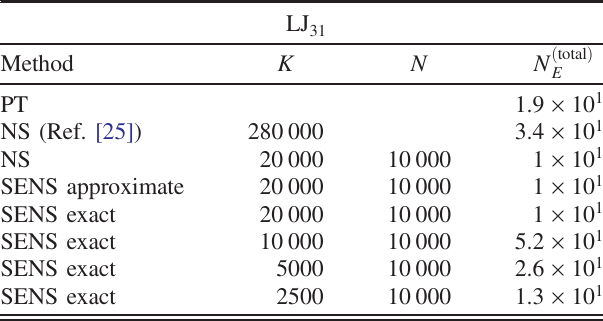
TABLE I. Comparison of methods used to obtain the LJ 31 heat capacity curves shown in Figs. 1 and 2. N ð total Þ indicates the total E number of energy evaluations (summed over all processors). PT was performed using 24 replicas spread geometrically through the temperature range 0.0125 to 0.6. Note that approximate SENS can perform as well as exact SENS when fewer replicas are used; in the interest of brevity, we do not include these results, as the LJ 75 calculations illustrate clearly the capabilities of the